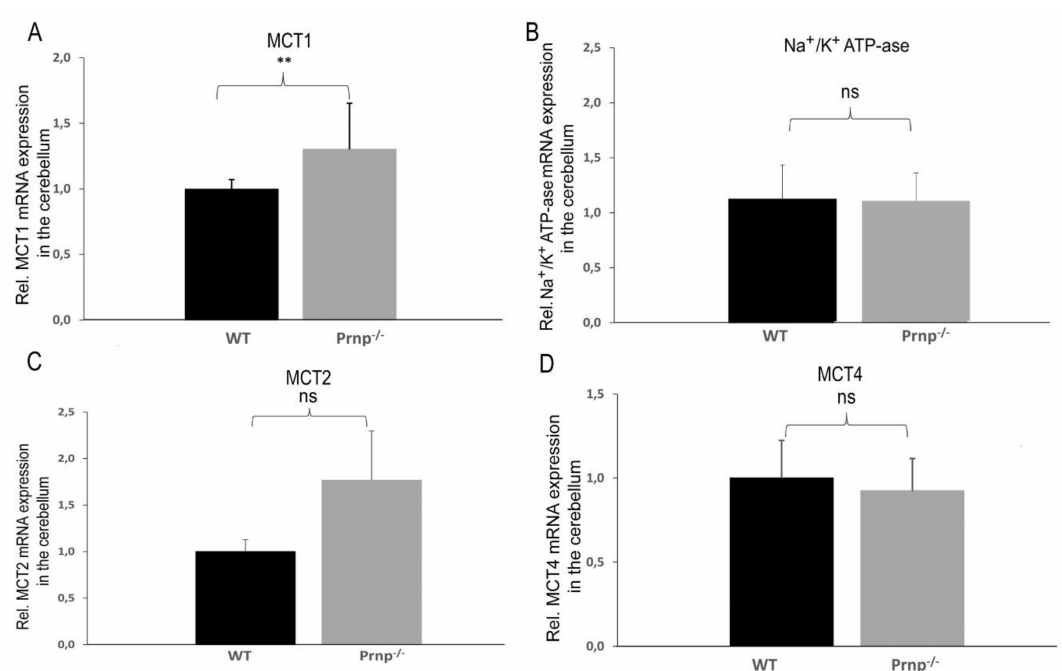
Figure 3. ( A – D ). Differential mRNA expression of MCT1 , MCT2 , MCT4 and Na + /K + ATP-ase α 2 subunit in the cerebellum of WT and Prnp − / − mice. The mRNA expression level of MCT1 was significantly increased in the cerebellum of Prnp − / − vs. a control group, while MCT2 , MCT4 and Na + /K + ATP-ase α 2 subunit expression remained unchanged. Sample size of WT group: n = 5; Prnp − / − group: n = 6. Displayed are means ± SEM. A p -value < 0.01 is considered as very significant (**) and ≥ 0.05 as not significant (ns).